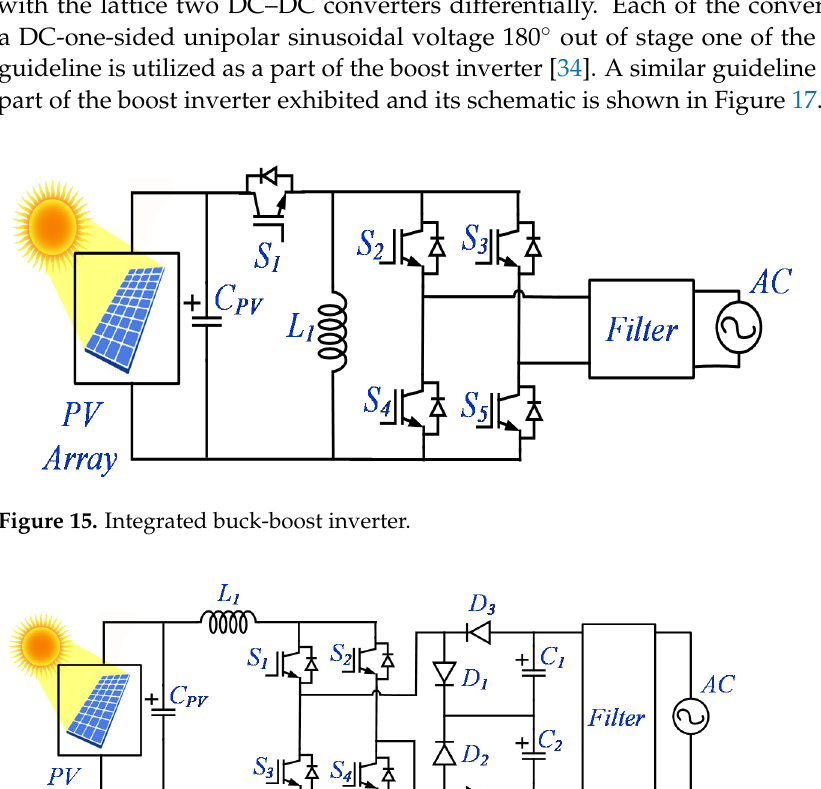
10 of 28 Figure 13. Universal single-stage grid-connected inverter .